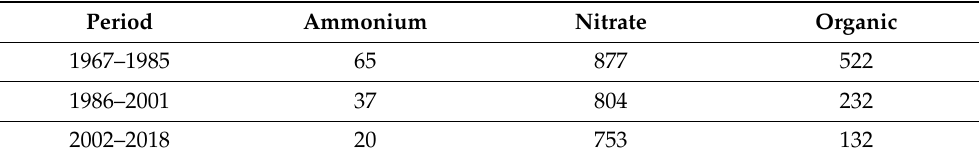
Table 1. Multiannual averages of forms of nitrogen loads (ton/year) migrated from the drainage basin through the River Jordan (measured at Huri Station) during three periods: (1) 1967–1985, immediately after the Hula Valley drainage; (2) 1986–2001, after the implementation of the Hula Reclamation Project; (3) 2002–2018, under changes in climate